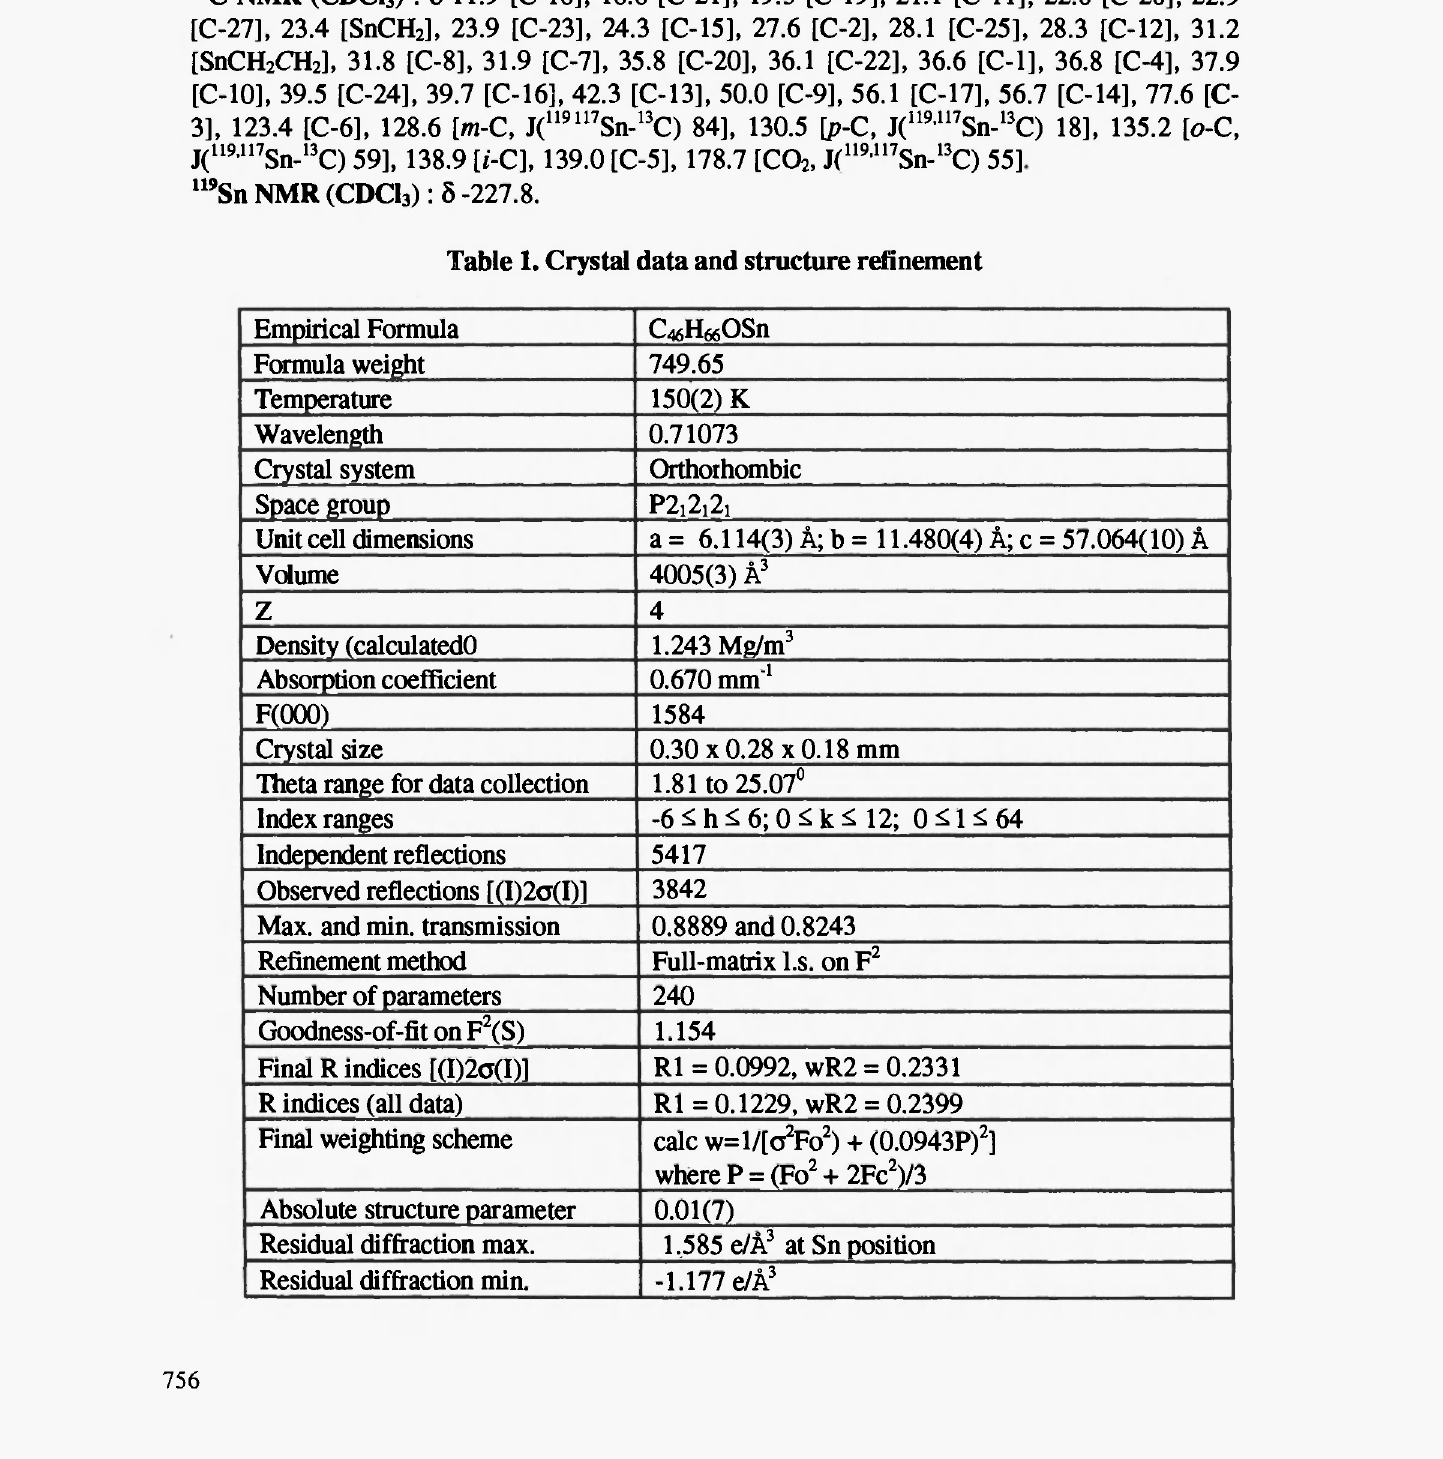
Table 1. Crystal data and structure